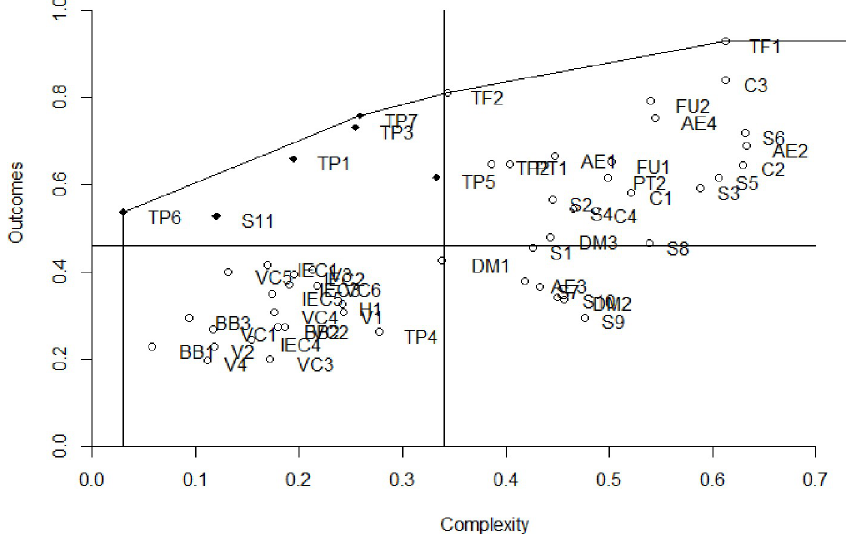
Fig 3. Selected Interventions’ complexity and outcomes representation.